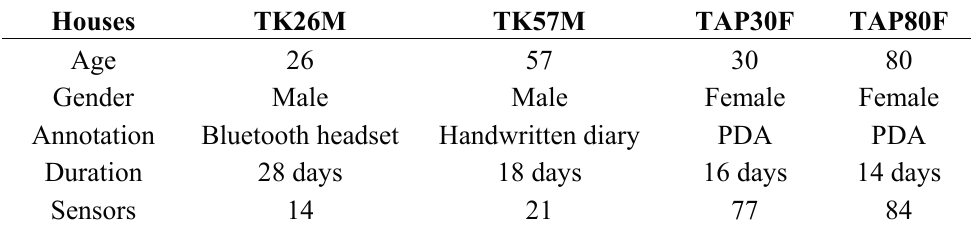
Table 1. House settings description.